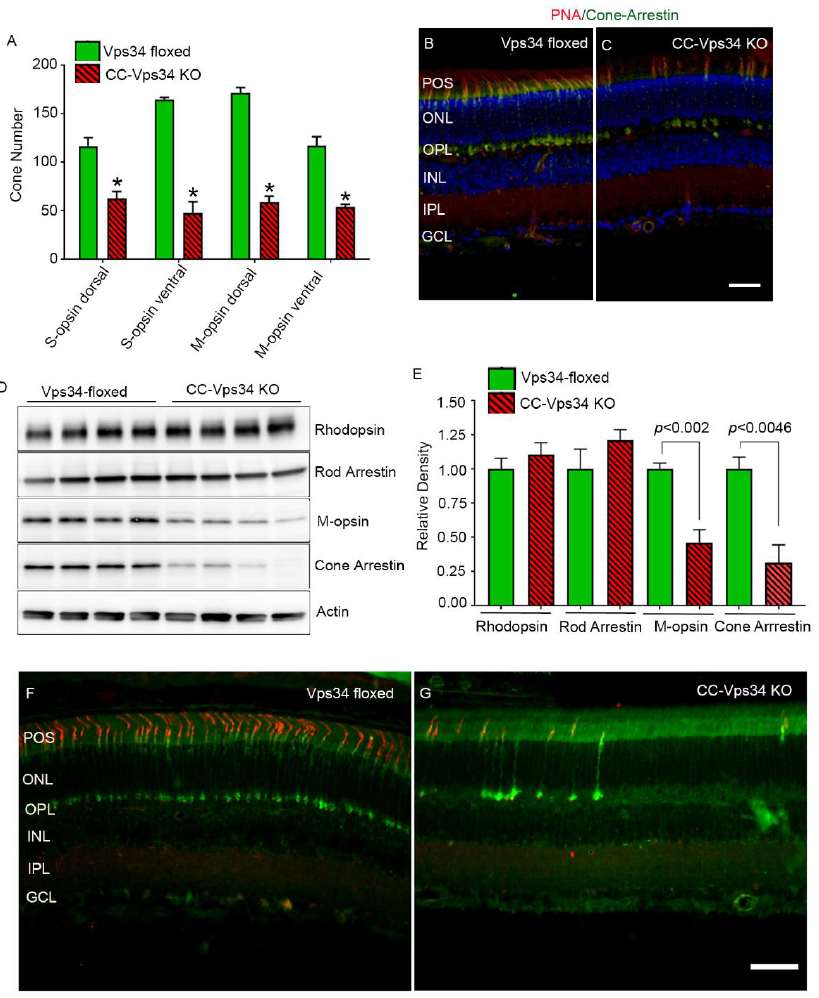
Figure 5. Structural characterization of Vps34-floxed and CC-Vps34 KO mouse retina. Quantification of the number of S-opsin and M-opsin positive cones in dorsal and ventral regions of the retina counted starting from the optic nerve head ( A ). Data are mean ± SEM ( n = 6). Significance, if any, is indicated on each panel. Prefer-fixed sections of 6-week-old Vps34-floxed and CC-Vps34 KO mouse retinas were subjected to immunofluorescence with PNA lectin (red) and anti-cone arrestin (green) antibody. * p < 0.05 ( B , C ). Scale bar = 50 μm. Retinal homogenates (5.0 μg protein) from four independent 6-week-old Vps34-floxed and CC-Vps34 KO mice were subjected to immunoblot analysis with anti-rhodopsin, anti-rod arrestin, anti-M-opsin, anti-cone arrestin, and anti-actin antibodies ( D ). The photoreceptor protein expression was normalized to actin ( E ). Data are mean ± SEM ( n = 4). Significance, if any, is indicated on each panel. Prefer-fixed sections of 32-week-old Vps34-floxed and CC-Vps34 KO mouse retinas were subjected to immunofluorescence with PNA lectin (red) and anti-cone arrestin (green) antibody ( F , G ). POS, photoreceptor outer segments; ONL, outer nuclear layer; OPL, outer plexiform layer; INL, inner nuclear layer; IPL, inner plexiform layer; GCL, ganglion cells. Scale bar = 50 μm. Full-length blots are presented in the Supplementary Materials.